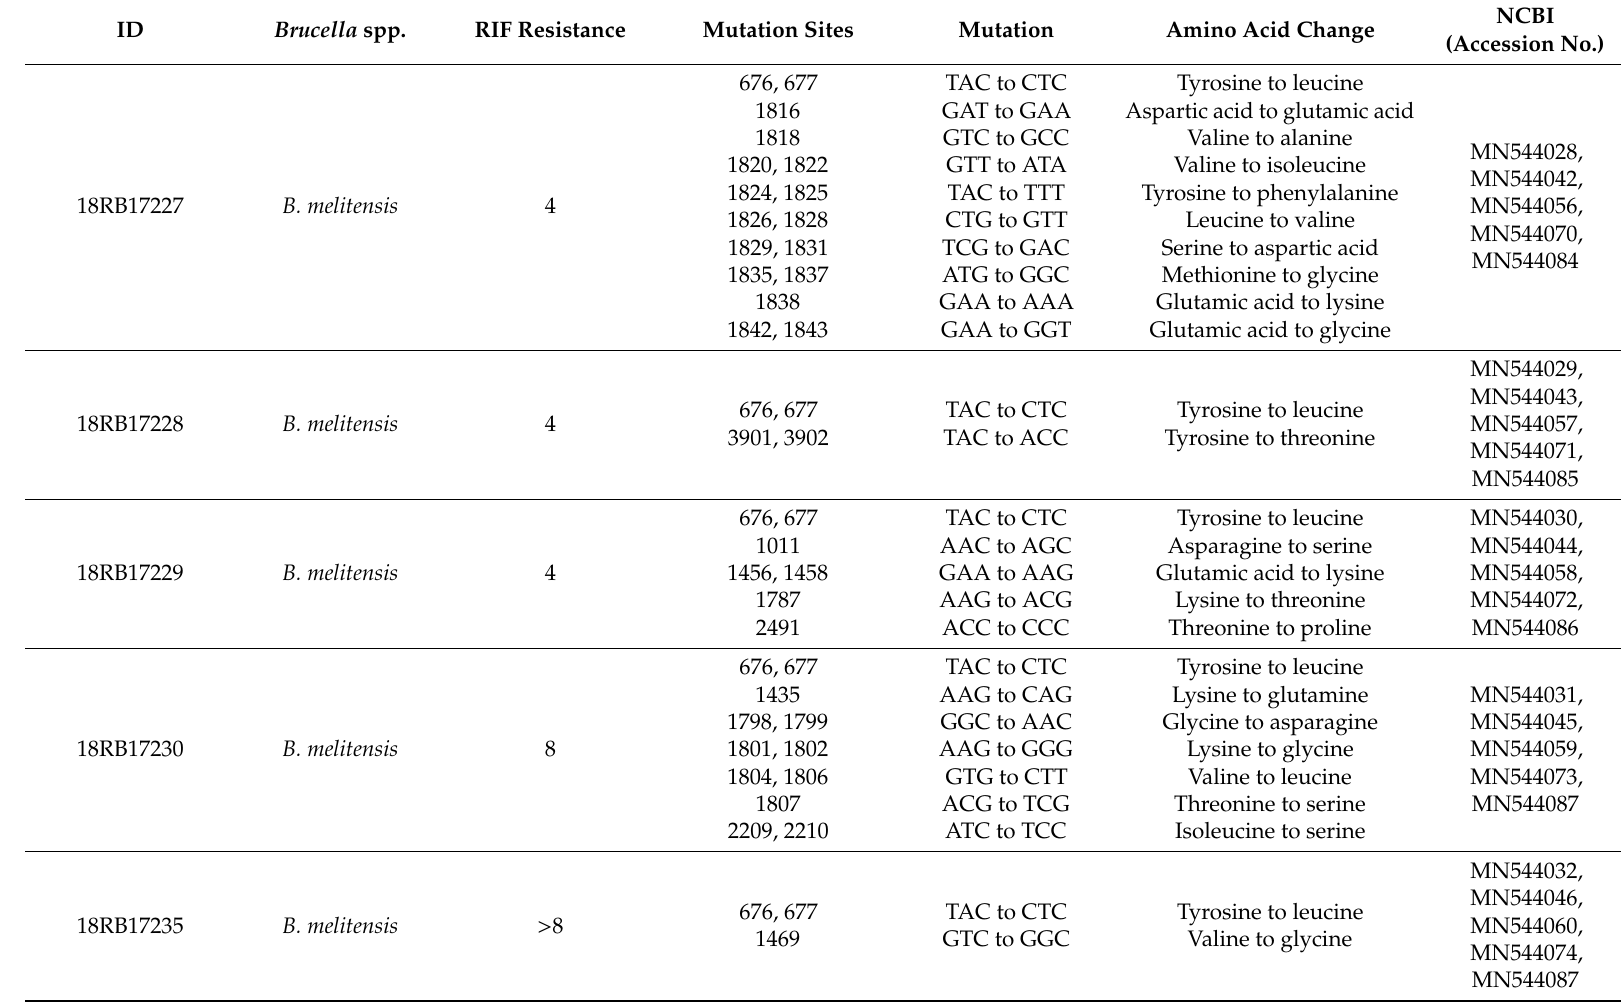
Table 3. Detection of mutations in rpo B gene associated with rifampicin resistance in B. melitensis and B. abortus